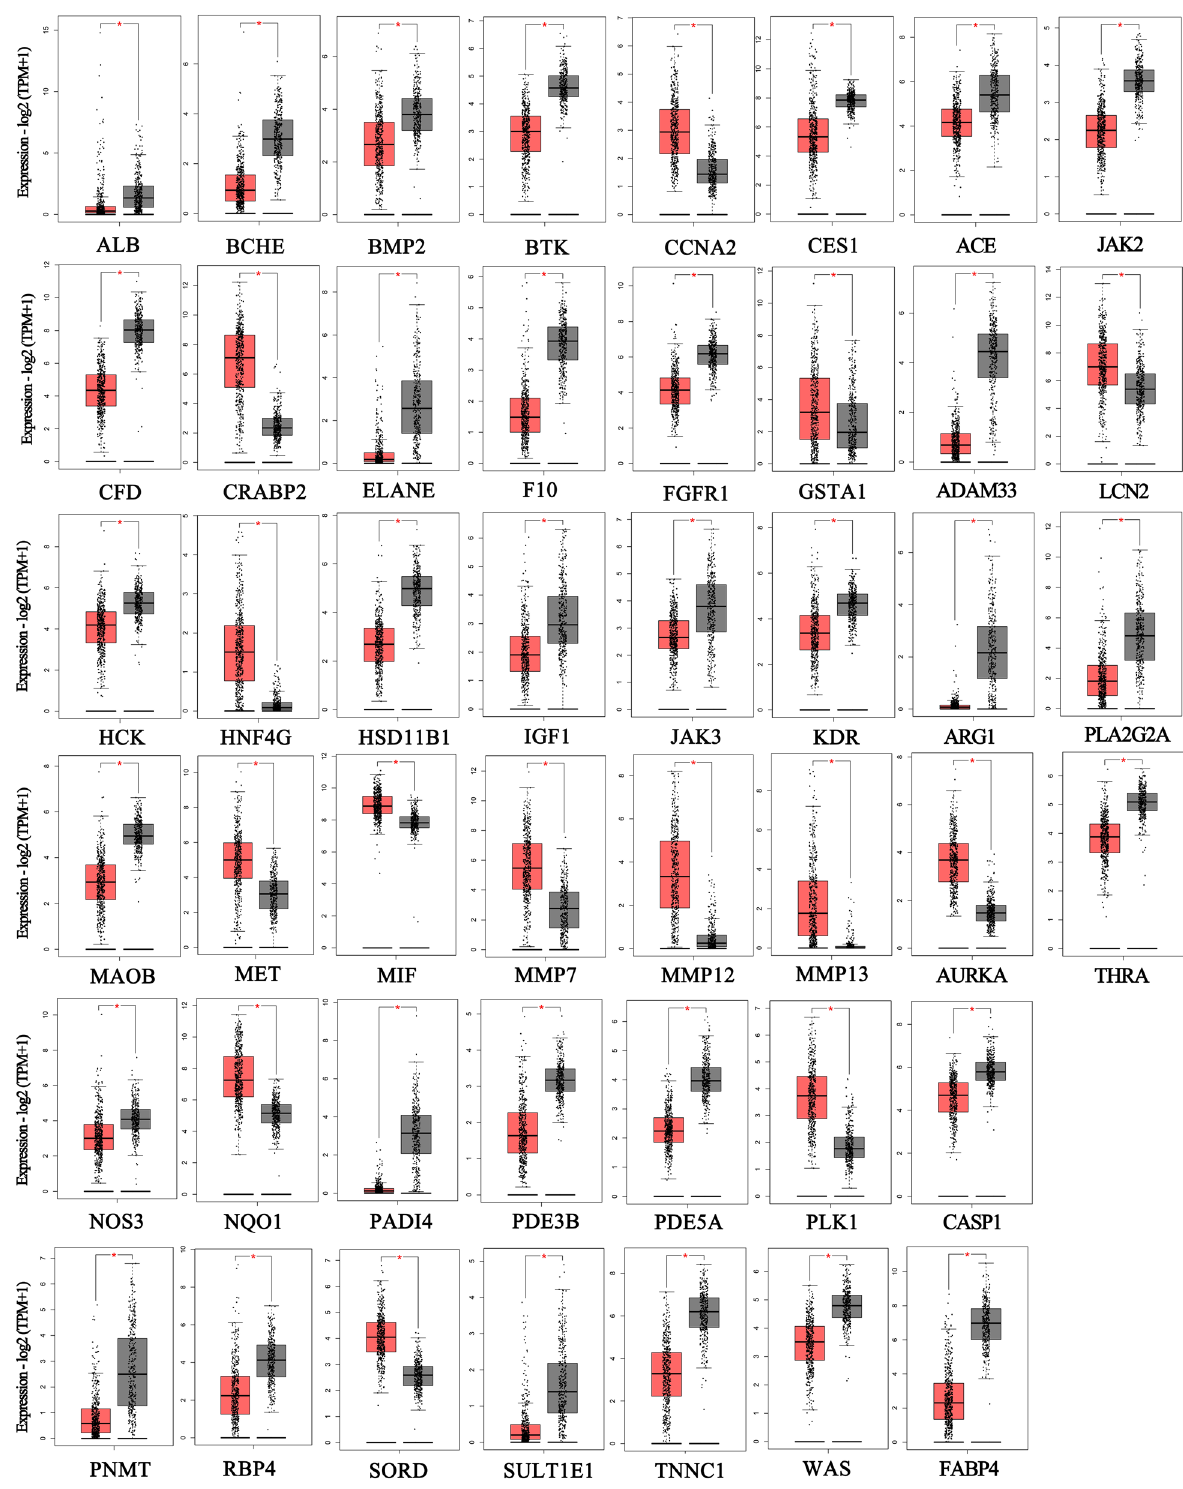
Figure 3. GEPIA analyzed genes that are significantly differentially expressed in LUAD. Red color represents tumor tissue, and black color represents normal